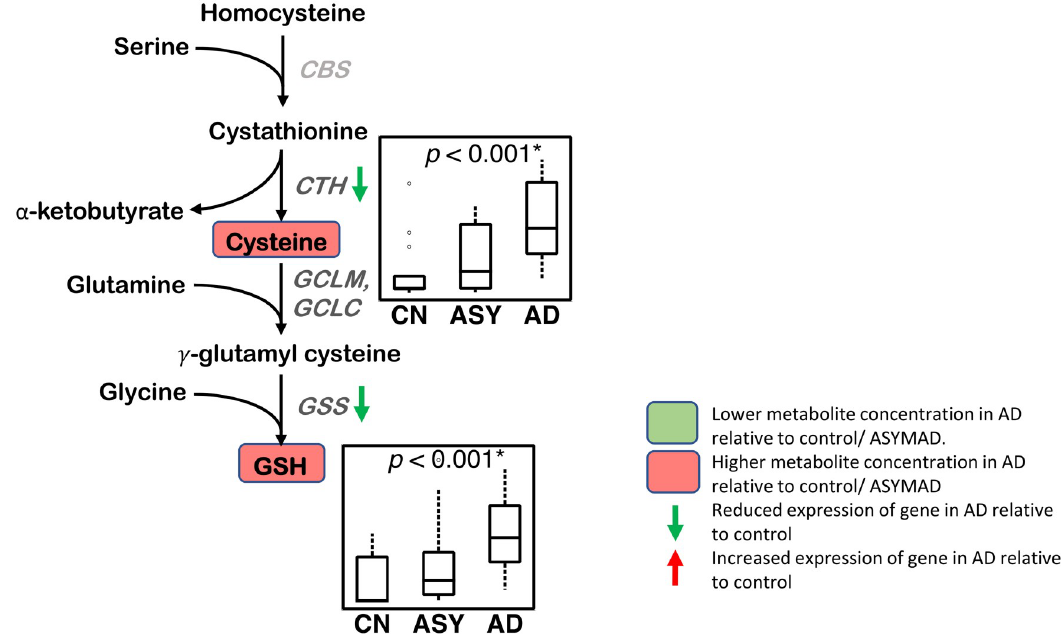
Fig 5. Transsulfuration and glutathione synthesis. Higher concentrations of cysteine and GSH are observed in AD in the ITG. Differential gene expression of enzymatic regulators of transsulfuration and glutathione synthesis are observed in the hippocampus/ ERC in AD relative to controls. CTH and GSS genes have reduced expression in the hippocampus/ERC in AD compared to CN. Sample size: AD = 17, ASY = 13, CN = 13; p -values indicate significance after FDR correction for multiple comparisons. An asterisk ( � ) indicates metabolite was also significant after Bonferroni correction. AD, Alzheimer disease; ASY, asymptomatic AD; CBS, cystathione β -synthase; CN, Control; CTH, cystathionase; ERC, entorhinal cortex; FDR, false discovery rate; GCLC, γ -glutamyl cysteine ligase; GCLM, glutamate-cysteine ligase modifier subunit; GSH, reduced glutathione; GSS, GSH synthetase; ITG, inferior temporal gyrus.